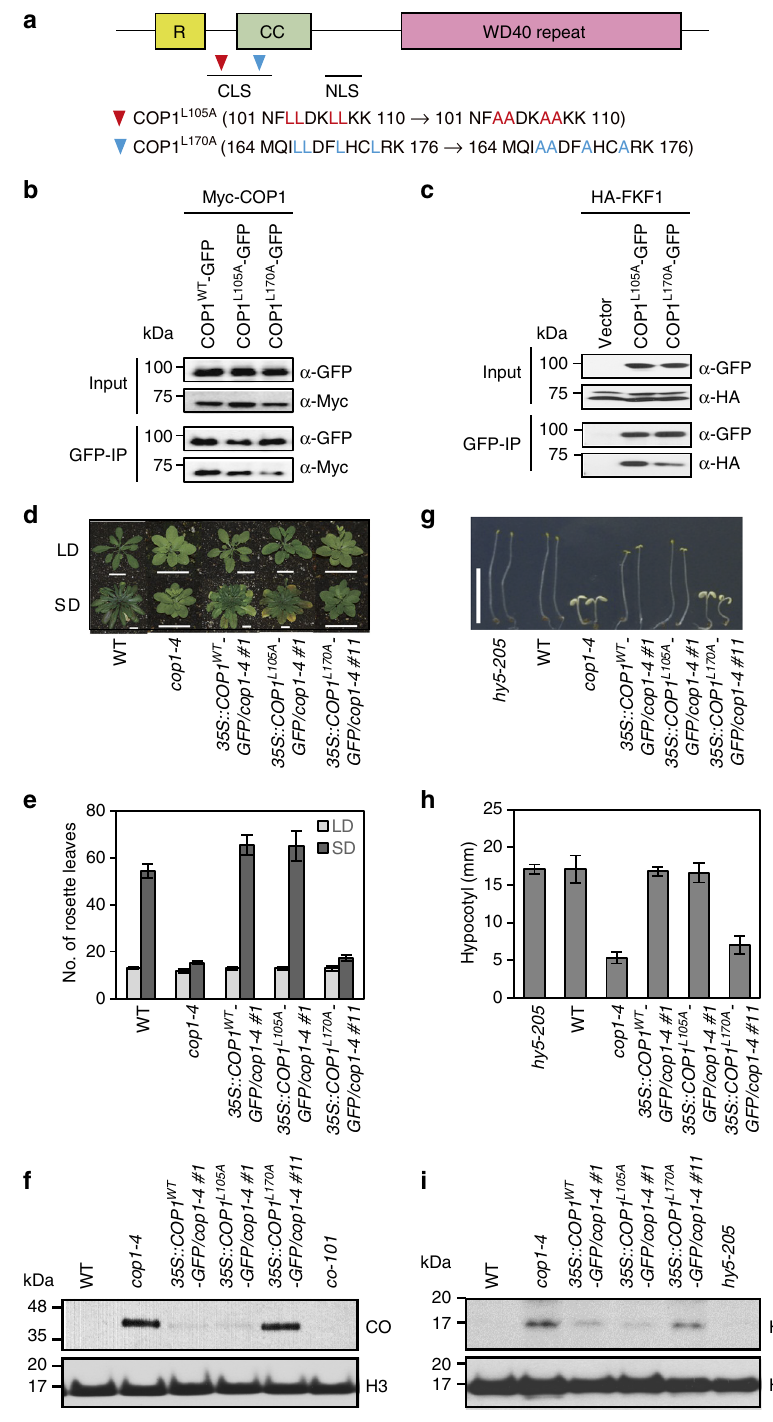
Fig. 5 COP1 variants that are unable to homo-dimerize are non-functional. a Mutation sites in the CLS motif of COP1. b COP1 L170A forms dimers poorly when compared with COP1 WT or COP1 L105A in N. benthamiana . c FKF1 interacts more weakly with COP1 L170A (poor dimer formation) than COP1 L105A (normal dimer formation) in N. benthamiana . d Various transgenic plants at bolting under LD and SD. Scale bars, 2 cm. e Flowering times of the plants in d . The number of rosette leaves at bolting represents the fl owering time of each genotype. Data are means ± s.d. of 20 plants. f CO accumulation of each genotype in d . Ten-day-old plants were harvested at ZT15 (1 h before dark) in LD. g Hypocotyl elongation of plants in d grown for 5 days in complete darkness. Scale bars, 1 cm. h Hypocotyl length of transgenic plants in darkness. Data are means ± s.d. of 20 plants. i HY5 accumulation in